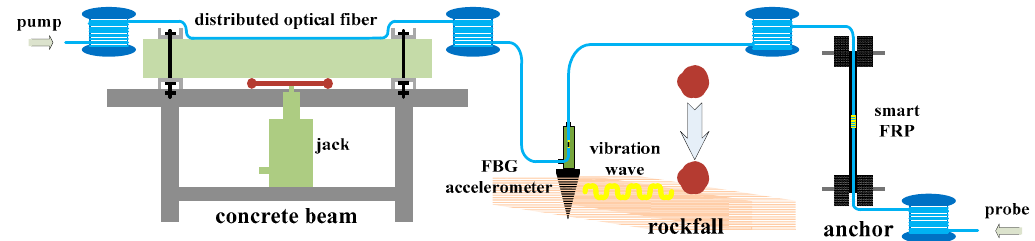
Figure 11. A schematic diagram of the simulated experimental system.